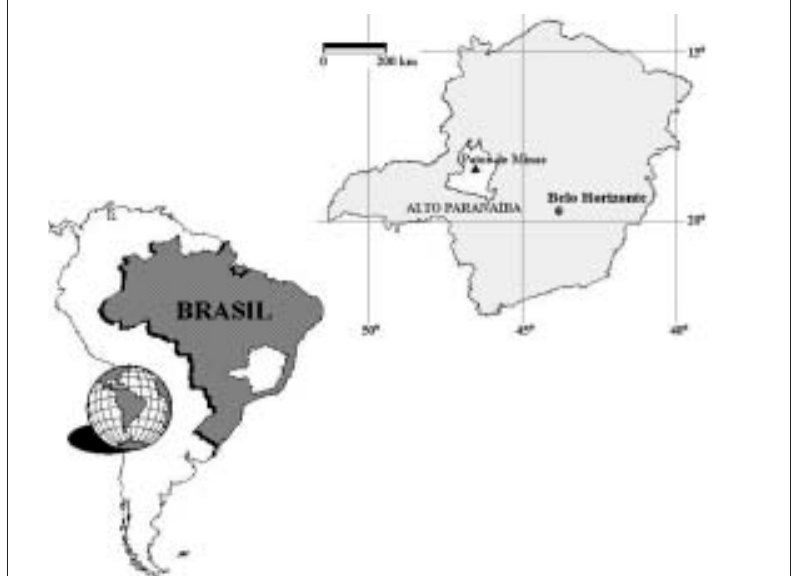
Figura 1. Mapa da localização geográfica do sítio de amostragem (perfis AP31 e AP33), tendo como referência a cidade de Patos de Minas, situada na região do Alto Paranaíba